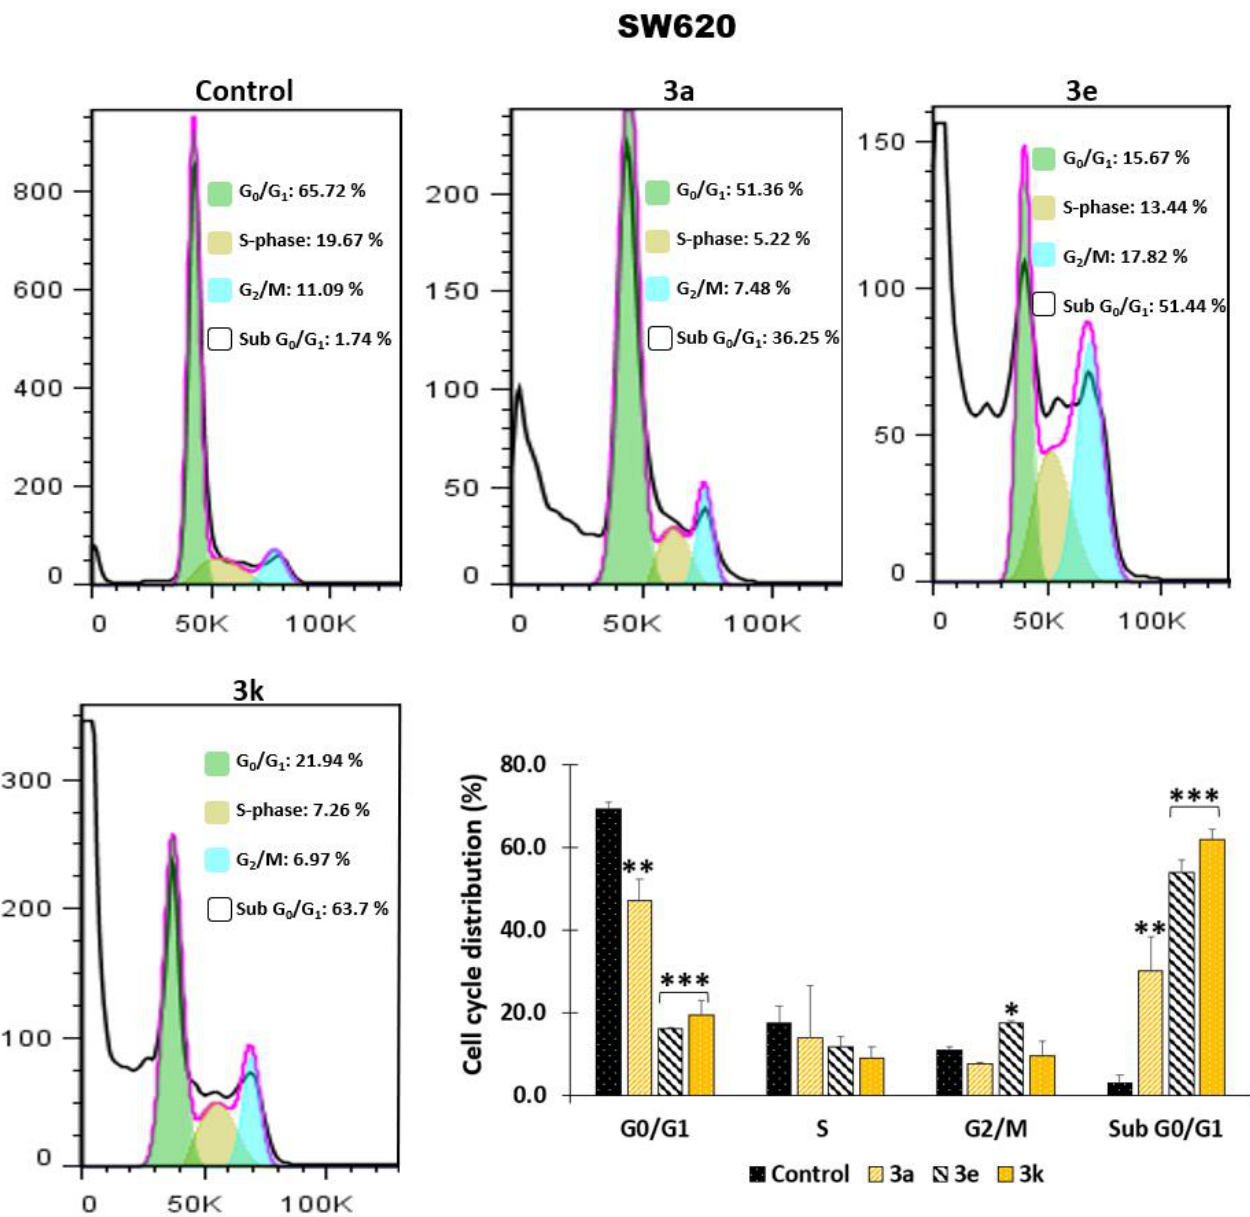
Figure 4. Cell cycle analysis of SW620 cells after treatment with DMSO (1%) or the hybrids based on curcumin/resveratrol. After 48 h of treatment, cells were labeled with PI and analyzed by DNA flow cytometry. The data indicate the percentage of cells in each phase of the cell cycle. All experiments were performed in duplicate and gave similar results. p values lower than 0.05 were considered statistically significant (* p < 0.05; ** p < 0.01; *** p < 0.001) .